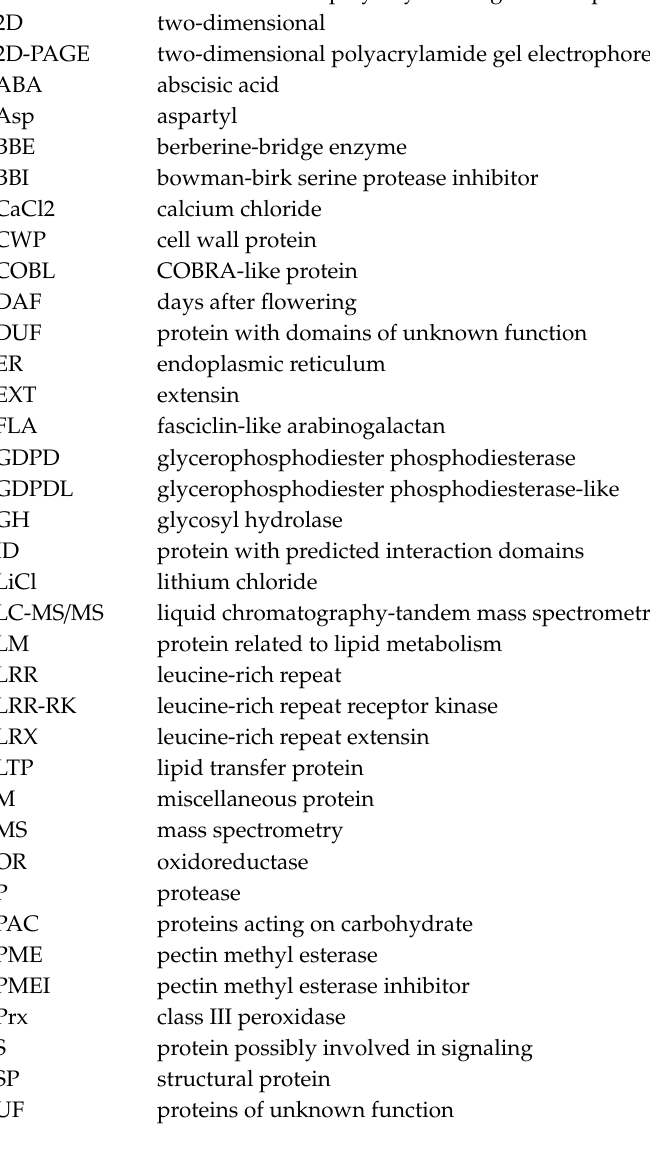
s1. Table S1. List of CWPs identified in A. thaliana (retrieved from WALLPROTDB [48]) and the accessions from B. distachyon , Saccharum spp. and O. sativa identified through BLASTp analysis; Table S2. List of CWPs identified in B. distachyon (retrieved from WALLPROTDB [48]) and the A. thaliana accessions identified through BLASTp analysis; Table S3. List of CWPs identified in Saccharum spp. (retrieved from WALLPROTDB [48]) and the A. thaliana accessions identified through BLASTp analysis; Table S4. List of CWPs identified in O. sativa